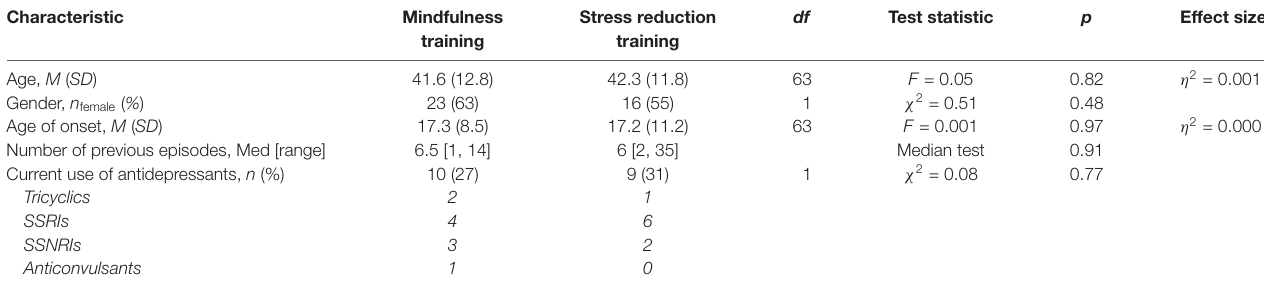
TABLE 1 | Sociodemographic characteristics, course characteristics and current use of antidepressants in depressed participants with valid EEG data who completed the mindfulness training ( n = 36) and depressed participants with Valid EEG data who completed the stress reduction training ( n = 29).